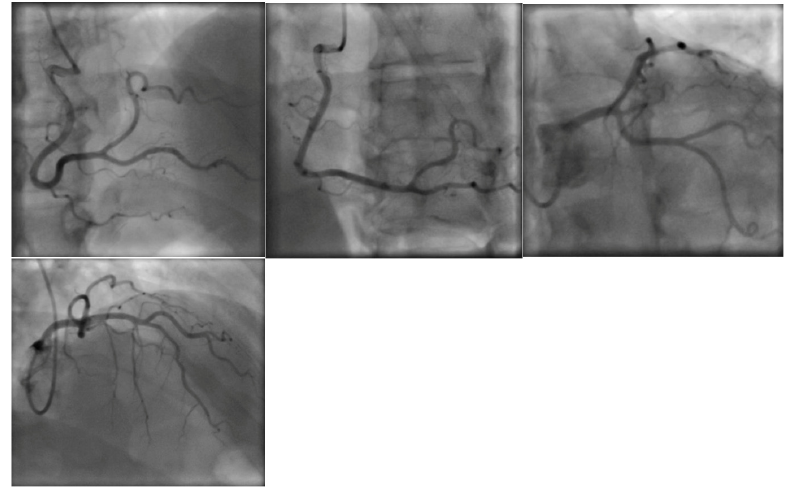
Figure 3. Cardiac catheterization performed on 28 October 22, which showed normal coronary ar ‐ teries and a low – normal ejection fraction of 50–55%.